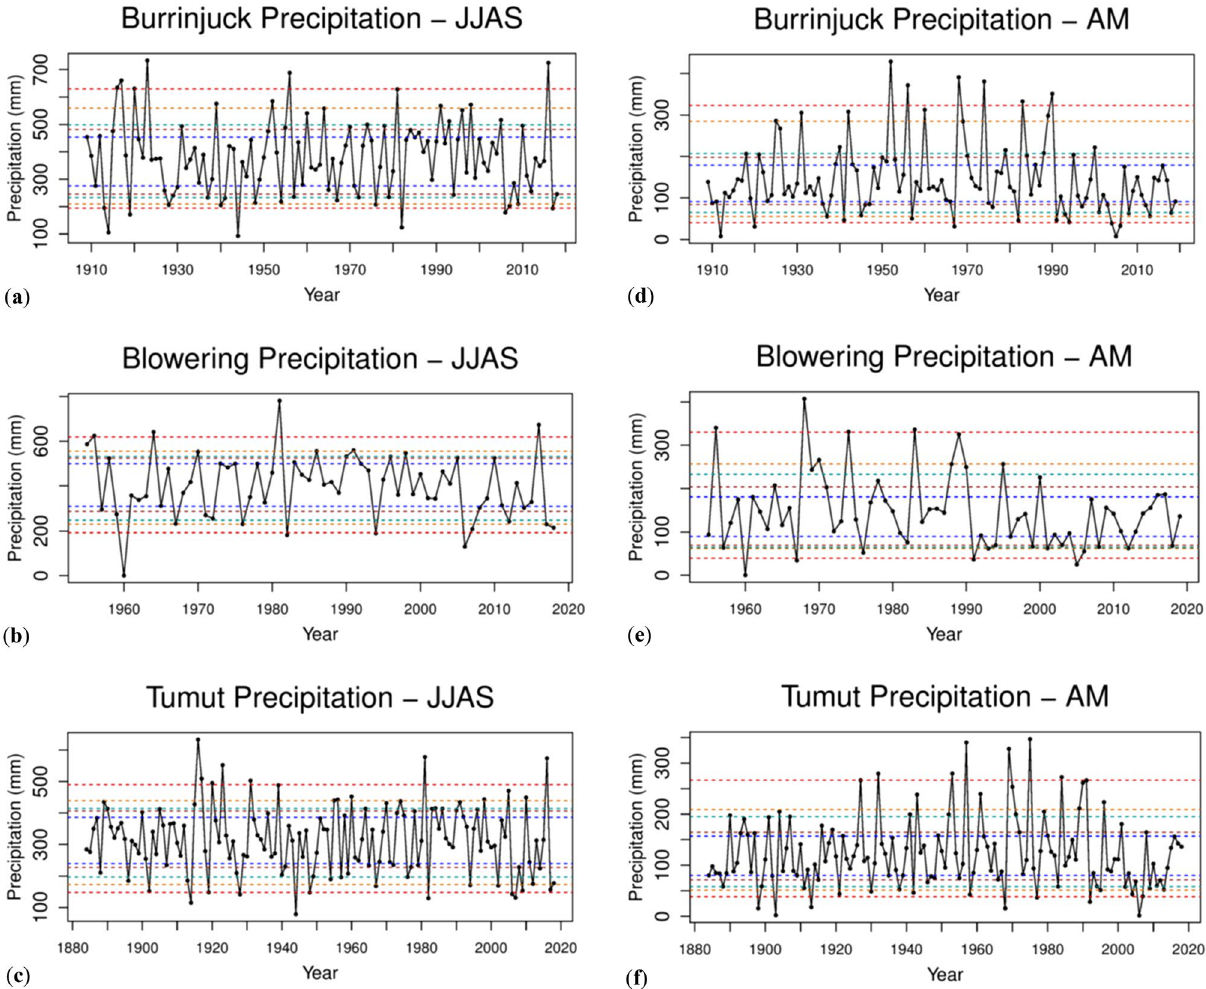
Figure 3. Precipitation time series in the Murrumbidgee River catchment area. JJAS precipitation at, ( a) Burrinjuck Dam from 1910 to 2019, ( b) Blowering Dam from 1955 to 2019 and ( c) Tumut from 1883 to 2019; April–May precipitation at, ( d) Burrinjuck Dam from 1910 to 2019, ( e) Blowering Dam from 1955 to 2019 and, ( f) Tumut from 1883 to 2019. Dashed lines indicate percentiles 5th and 95th (red); 10th and 90th (orange); 15th and 85th (light blue); 20th and 80th (brown); and 25th and 75th (dark blue). Note the decreasing April–May precipitation at the three stations since the early